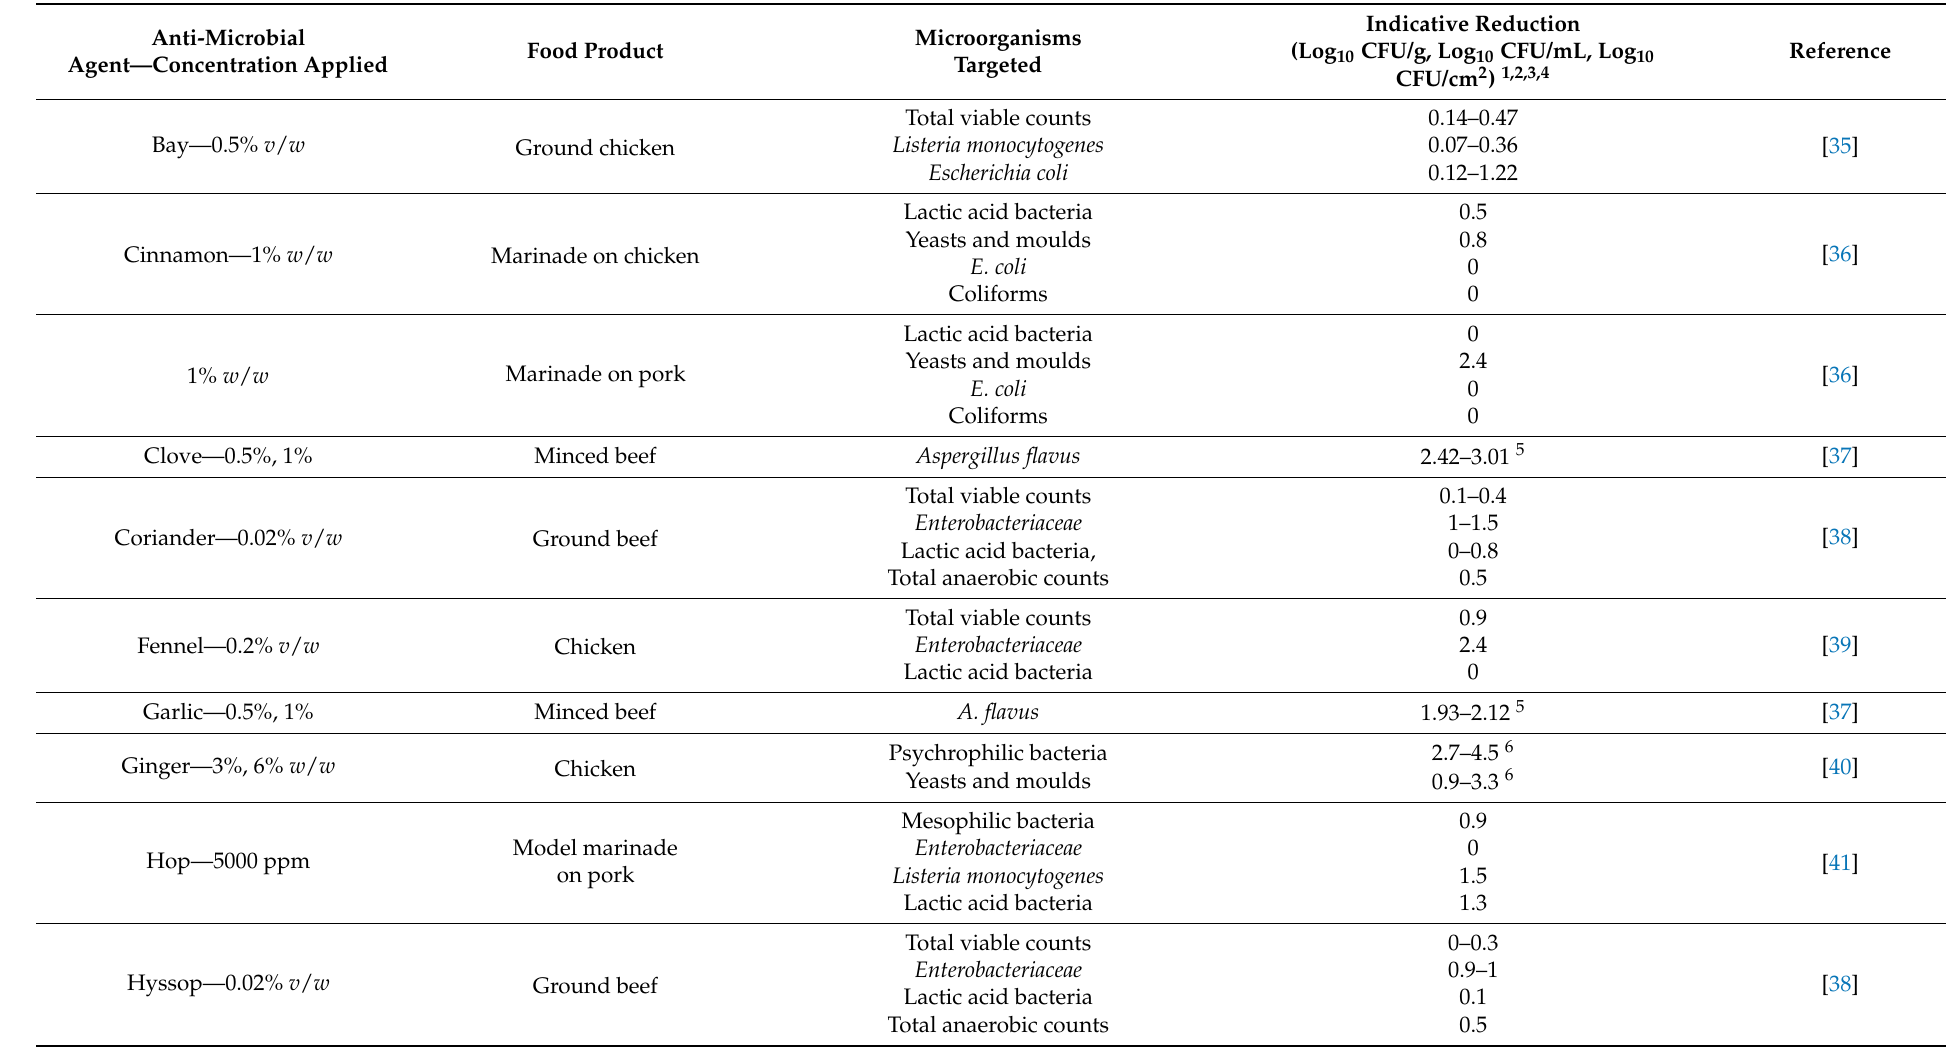
Table 1. Overview of studies testing the efficacy of essential oils and plant extracts or their components when added to meat